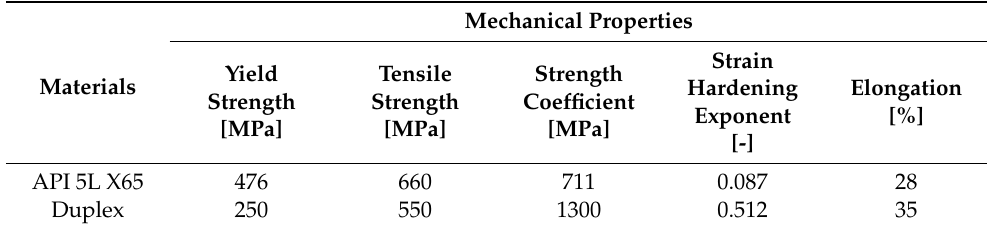
Table 3. Mechanical properties of inside and outside